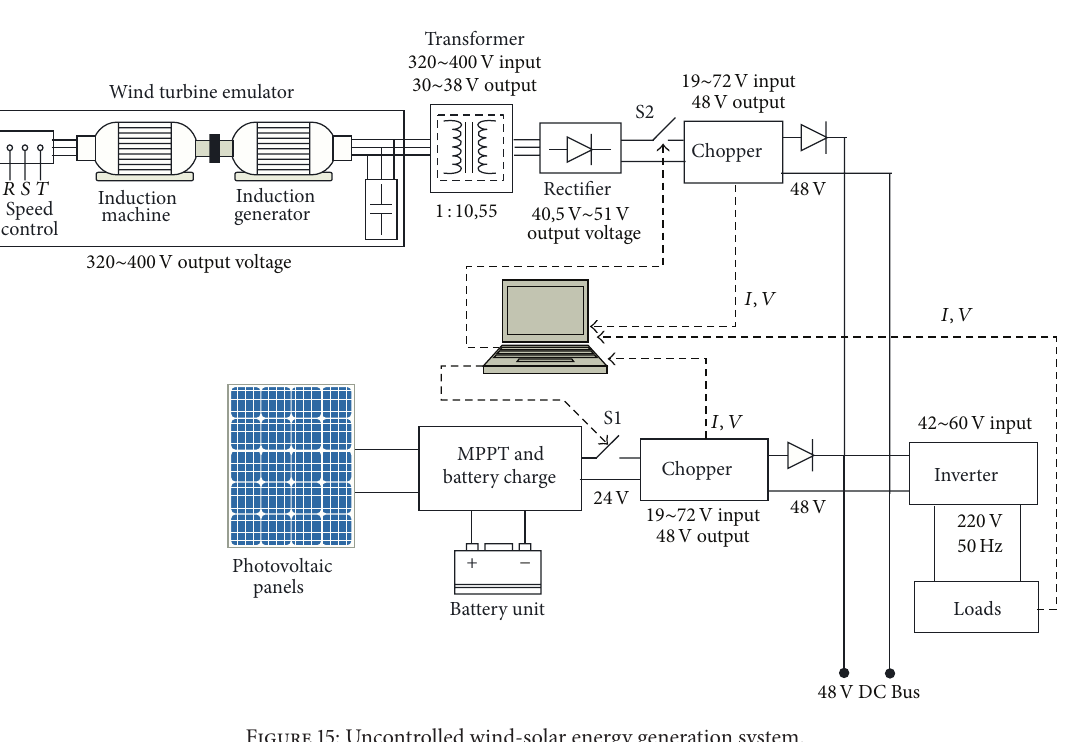
Figure 15: Uncontrolled wind-solar energy generation system.